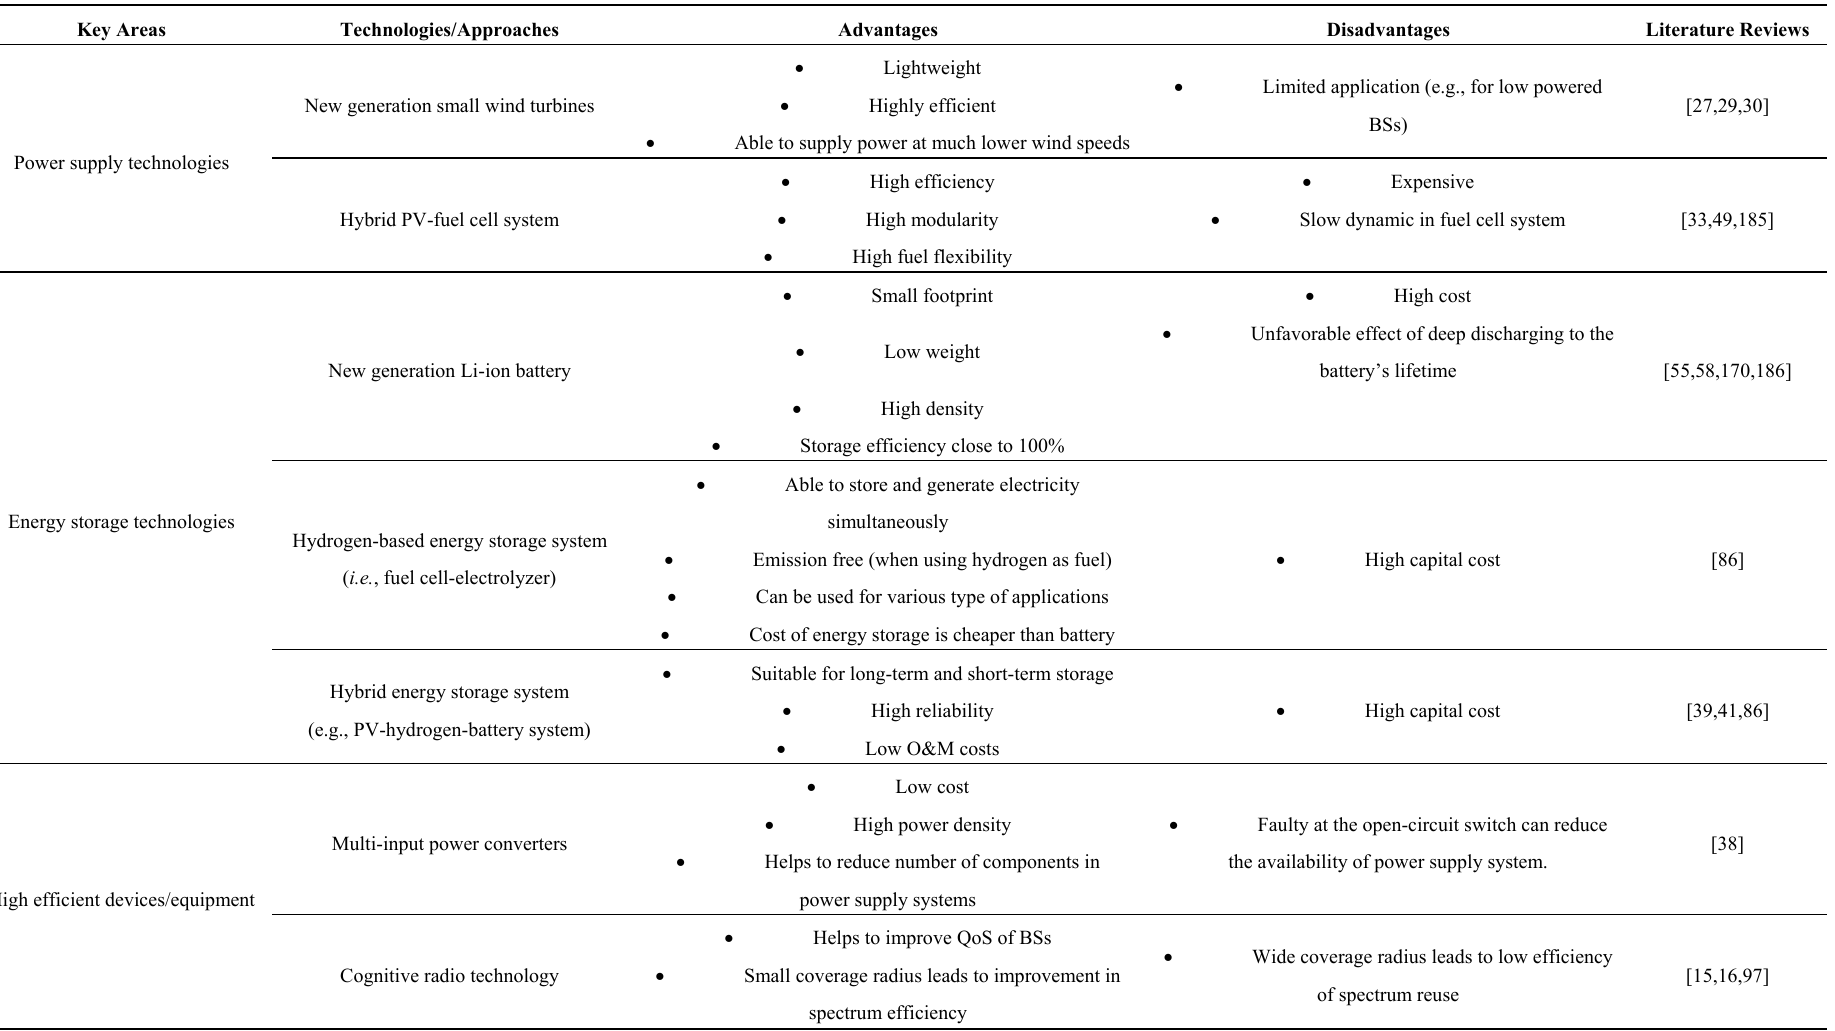
Table 2. Summary of promising technologies/approaches for energy efficient base